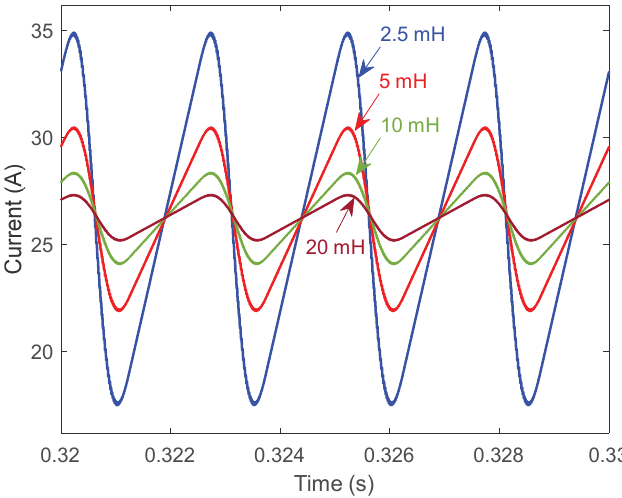
Figure 9. DC link currents as a function of various